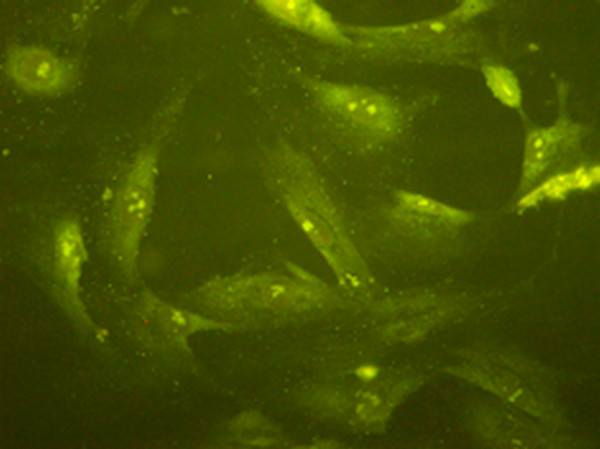
Immunofluorescence against α-actin suggests that the green staining cell is ASMC.